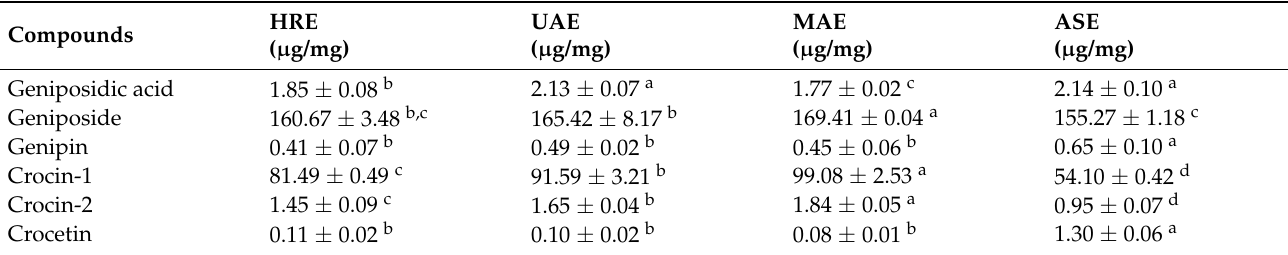
Table 5. Comparison of contents of six characteristic compounds in Gardeniae fructus extracts by different extraction methods (mean ± SD, n =